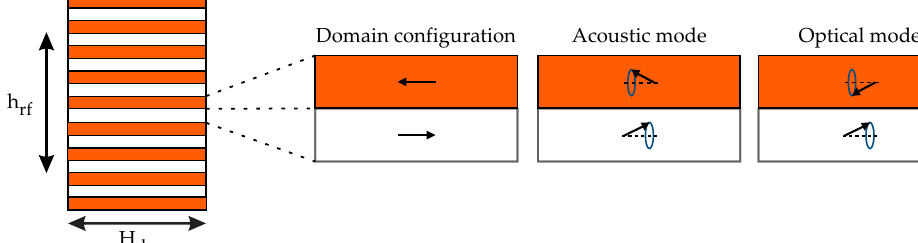
Figure 6. Schematic illustration of the stripe domain pattern for the coupled Py layer illustrating the precessional configurations for the acoustic and optical modes. Black arrows indicate the direction of the x -component of the in-plane magnetization m x in the coupled Py layer inside the stripe domains shown in orange and white